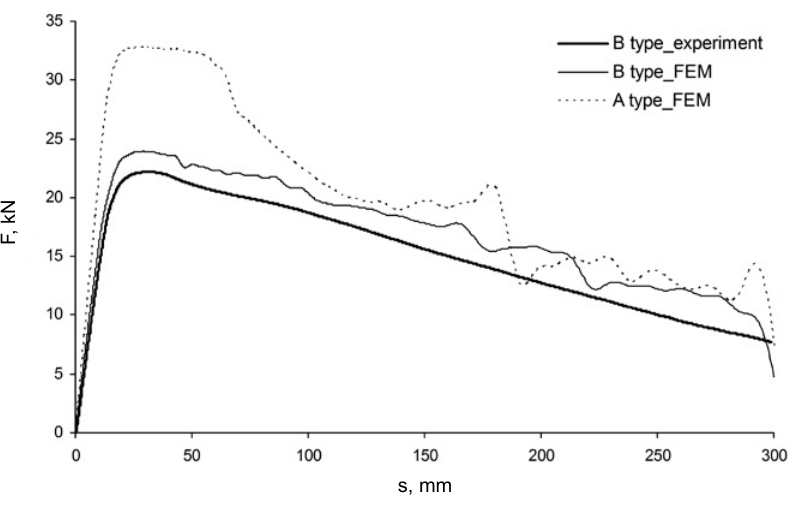
Figure 7. F ( s ) graphs obtained from three-point bend test of A and B guide rail segments